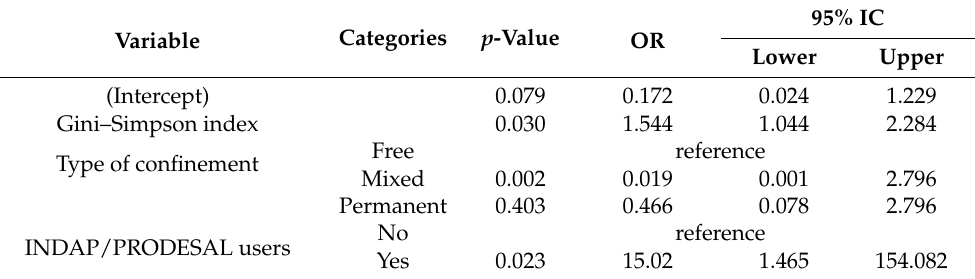
Table 8. Final model results from the multivariable logistic regression analysis. The p -value, odds ratio (OR) and 95% confidence interval (C.I.) with lower and upper limits are reported for risk factors associated with positivity to STEC and S. enterica in